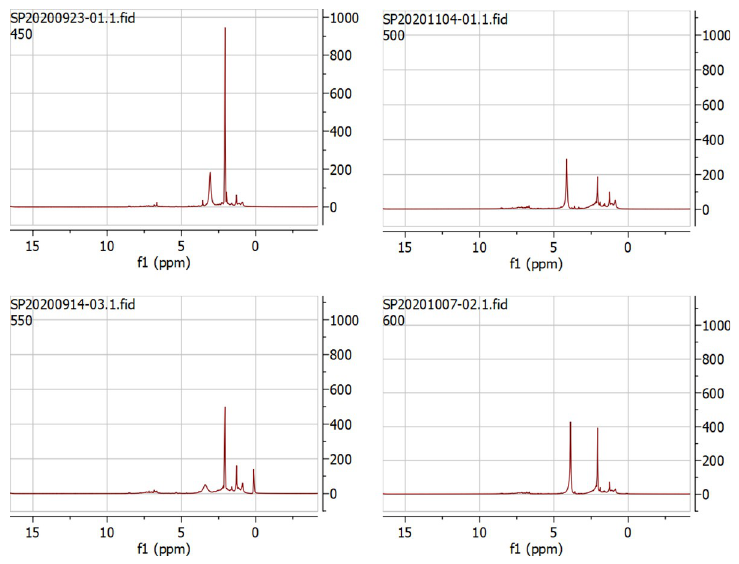
Fig 4. 1 H NMR spectra of the organic oils obtained in different temperature (a) 450˚C, (b) 500˚C, (c) 550˚C and (d)